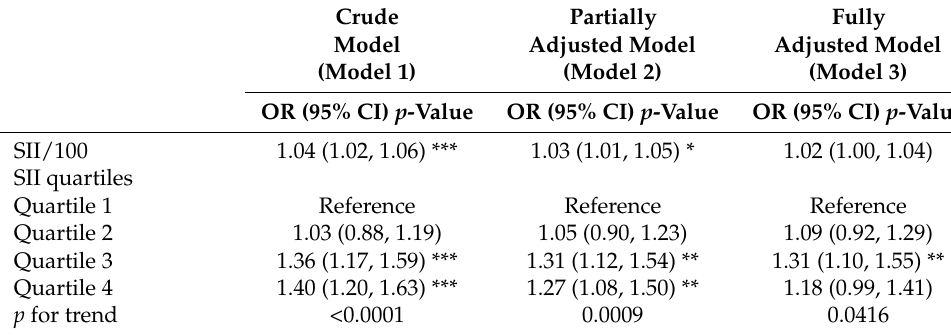
Table 3. The association between SII and hyperlipidemia.